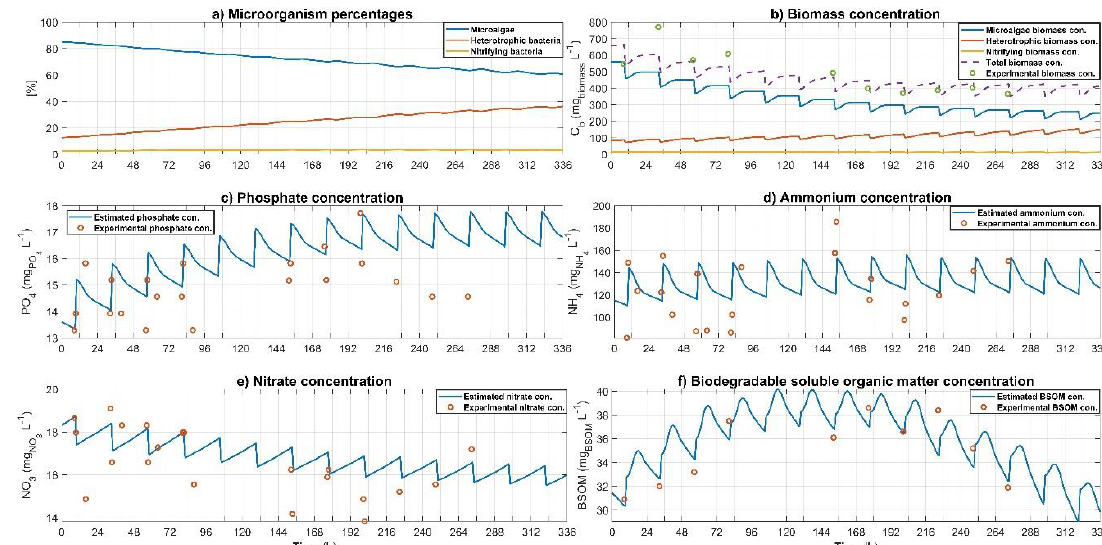
Figure 7. Validation results for the biomass production model with wastewater medium. ( a ) Microalgae and bacteria percentages inside the reactor; ( b ) Microalgae and bacteria biomass concentration; ( c ) Phosphate concentration inside the reactor; ( d ) Ammonium concentration inside the reactor; ( e ) Nitrate concentration inside the reactor; ( f ) Biodegradable soluble organic matter concentration inside the reactor.